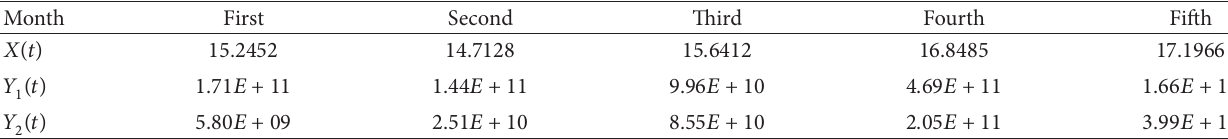
Table 7: The input and outputs center of gravity for DMU 6 .